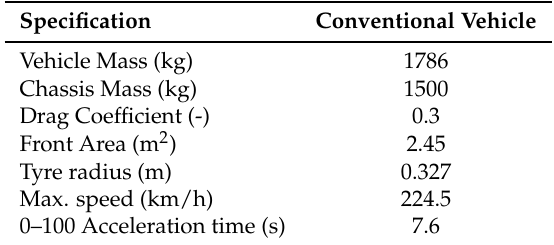
Table 2. Main specifications of the conventional vehicle [31].